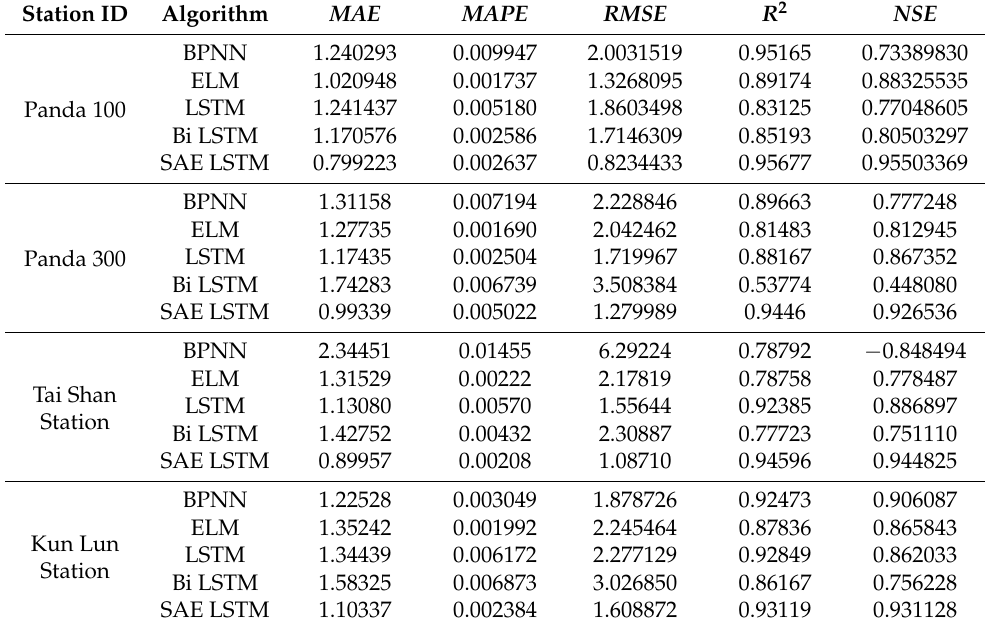
Table 6. Eight-hour temperature performance results from station Panda 100 to Kun Lun station.